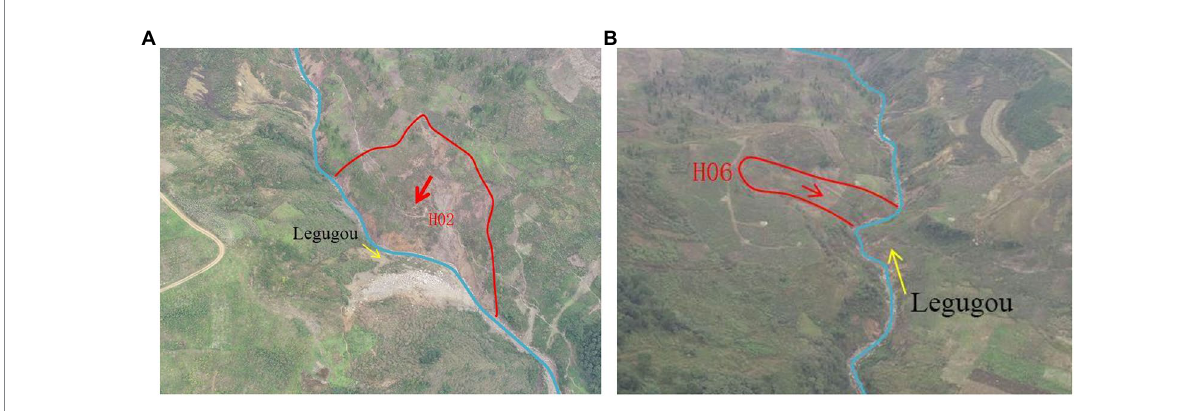
FIGURE 15 Landslide characteristics. (A) Landslide H02. (B) Landslide